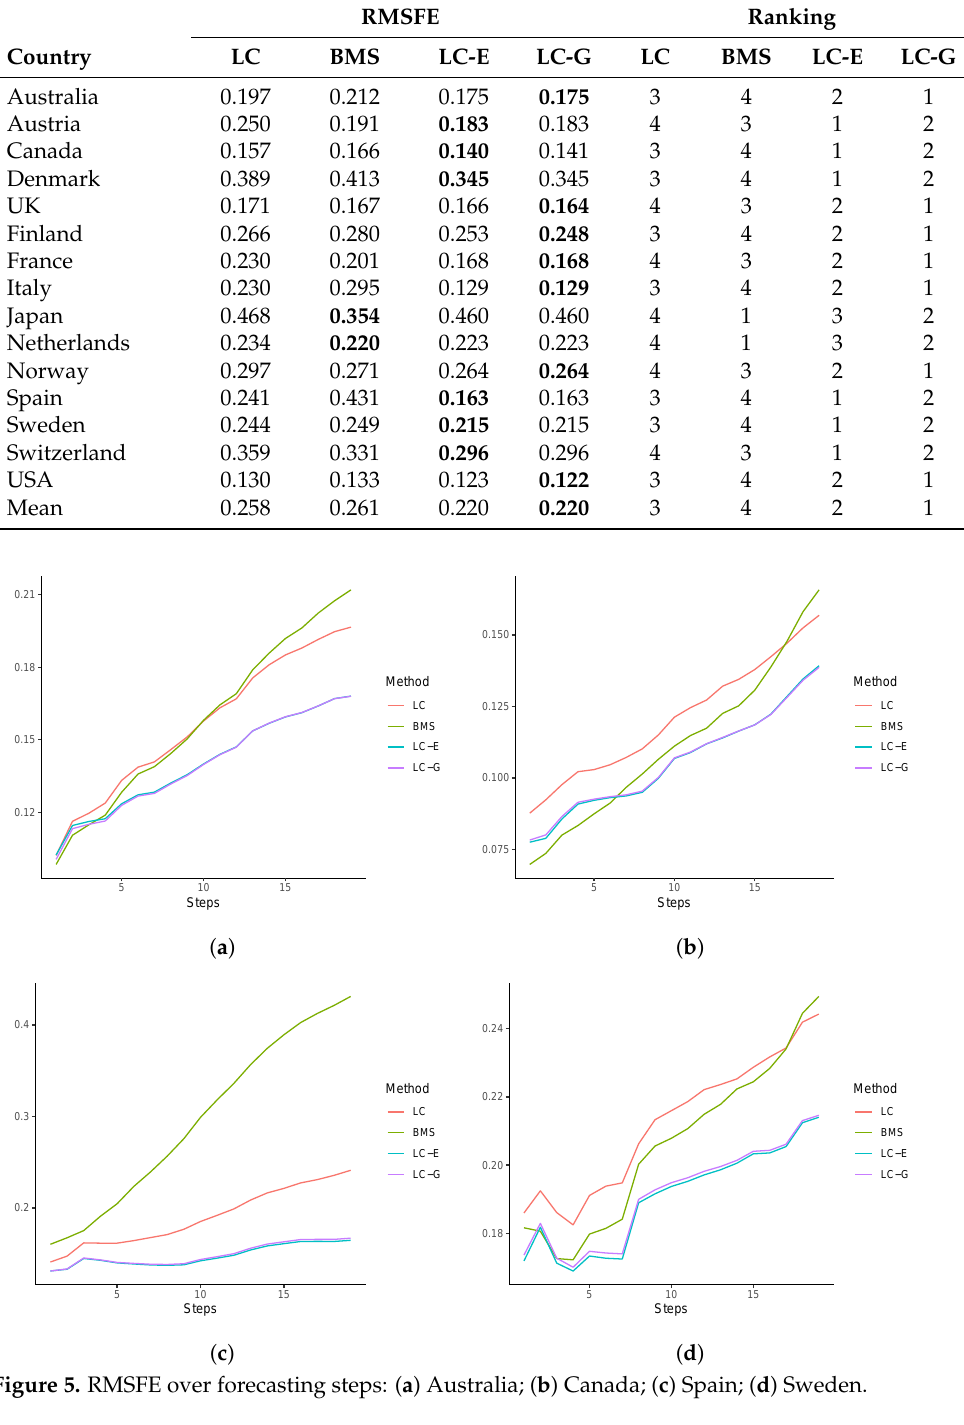
Table 2. Connecting rod parameter of PUMA560 robot.